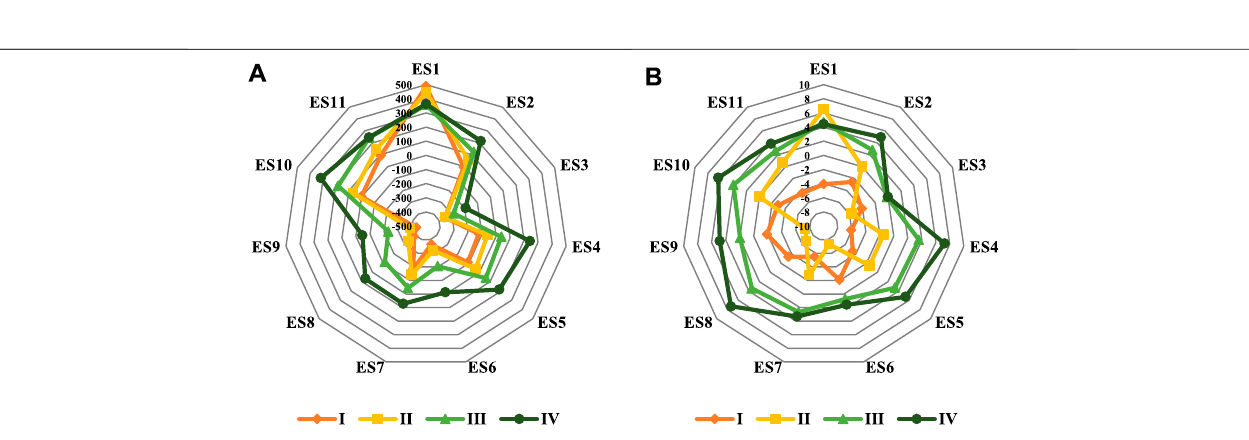
FIGURE 9 | Characteristics of ecosystem service supply and demand in four types of regions at a regional scale (A) and at a small scale (B) . Food (E1), materials (E2),water(E3),airqualityregulation(E4),climateregulation(E5),waterpuri fi cation(E6),regulationofwater fl ows(E7),erosionprevention(E8),maintenanceofsoilfertility (E9), habitat services (E10), cultural and amenity services